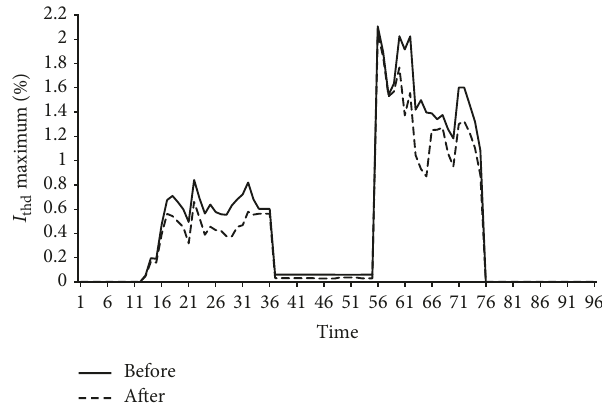
Figure 13: THD 𝑖 maximum for 24 hours with and without passive filter.